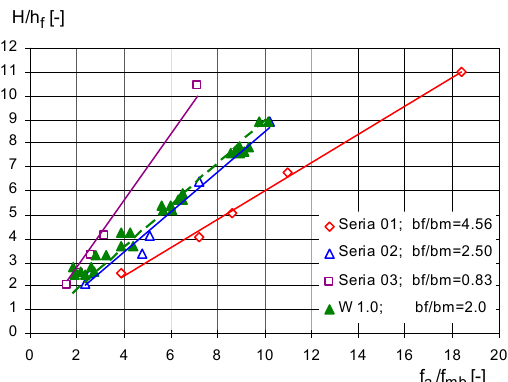
Figure 10. The values of the resistance coefficients of f a / f mb in the function of H/h f from our own research in the variant W 1.0, together with the results of Bretschneider and Özbek (1997) [16] for a series of experiments performed in a two-section channel with side slopes of 1:1. As it results from the Equation (5) for very narrow floodplains, with b f / b m = 1.0 and H/h f = 3, the